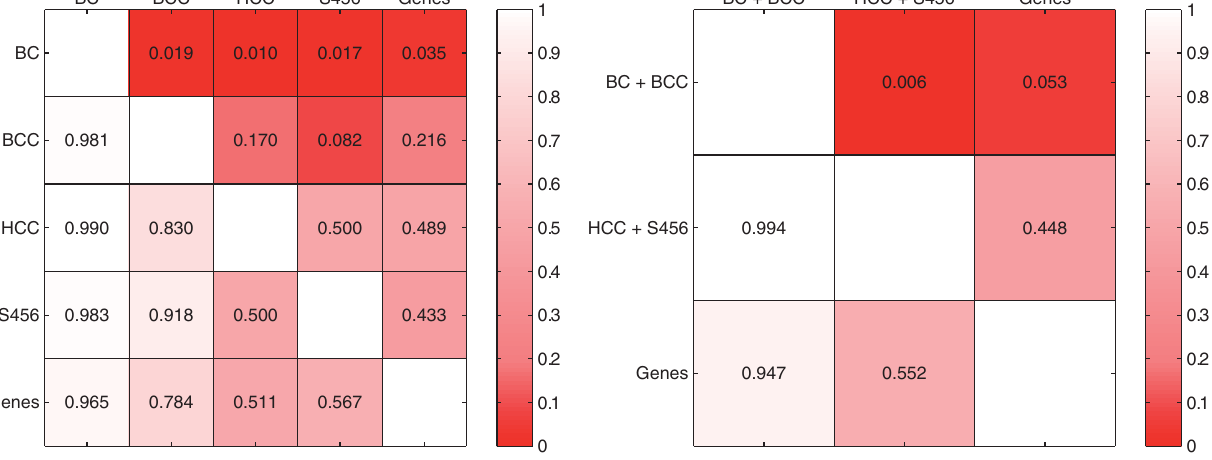
Figure 6. Pairwise comparison of the five feature types. Each cell (row=i, column=j) depicts the the p-value obtained by performing a one-sided Wilcoxon rank sum test with as alternative hypothesis that the median rank of type i is lower than type j, based on the AUCs achieved for each of the six experiments. The plot on the left shows individual comparisons, the plot on the right includes comparisons of groups of features. Cell-shading reflects the